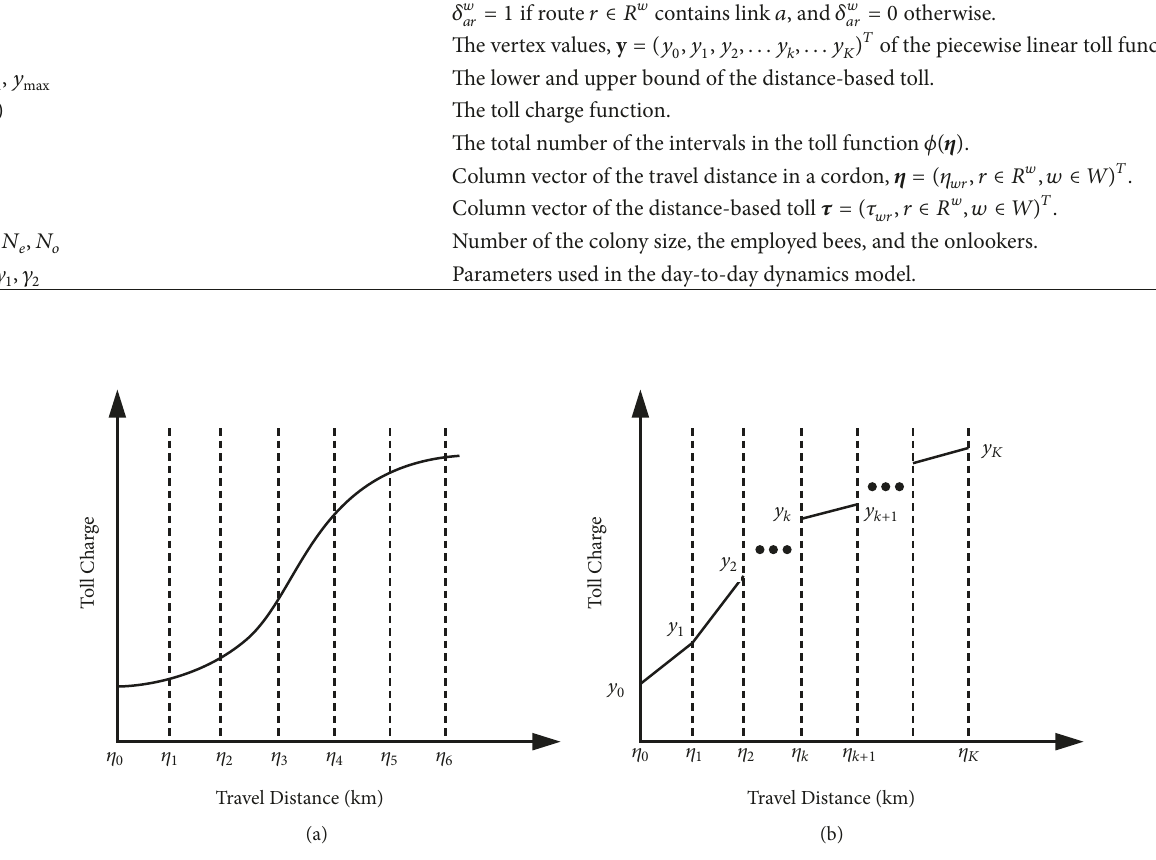
Figure 1: Piecewise linear